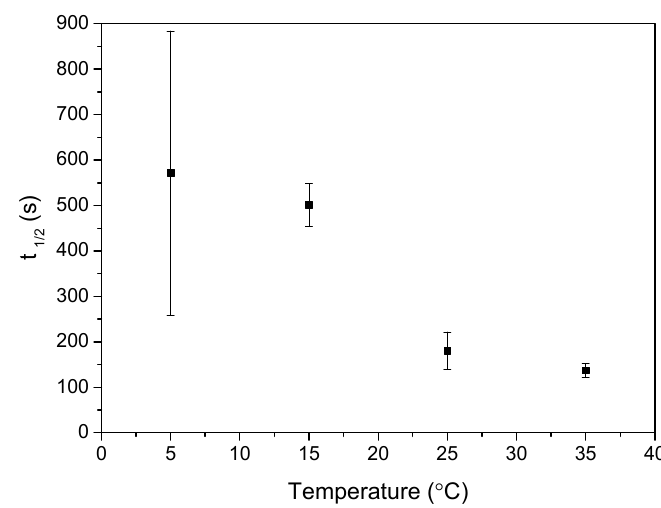
Figure 8. Dependence of the parameter t 1 / 2 on temperature with data points corresponding to mean values and their standard deviation values (error bars) from three experiments.